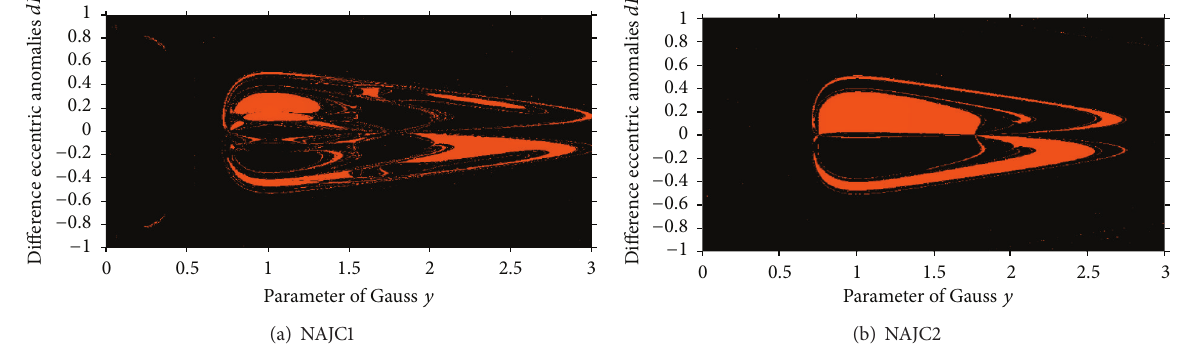
Figure 3: Dynamical planes from new methods and Reference Orbit